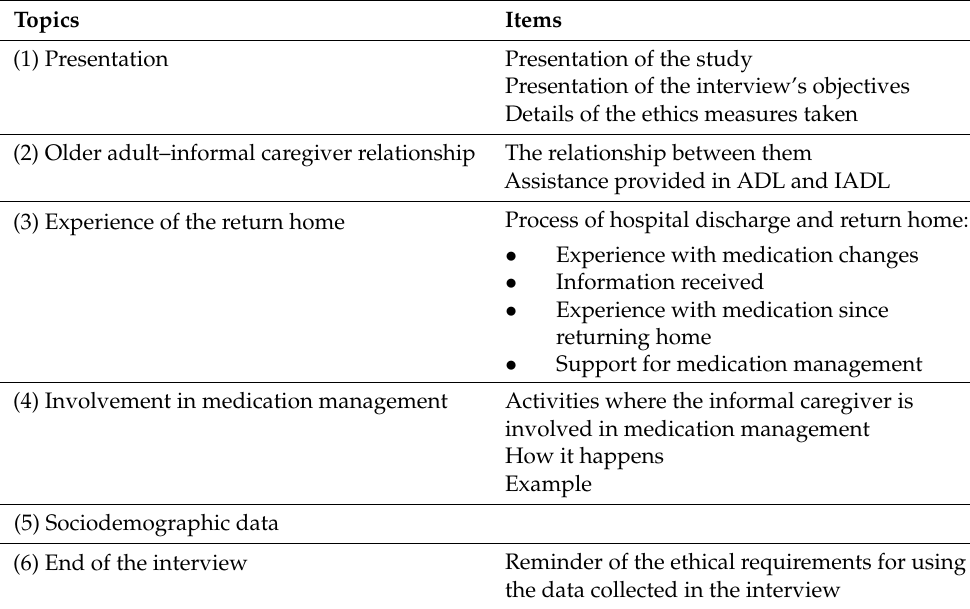
Table A3. Joint interview with the older adult and their informal